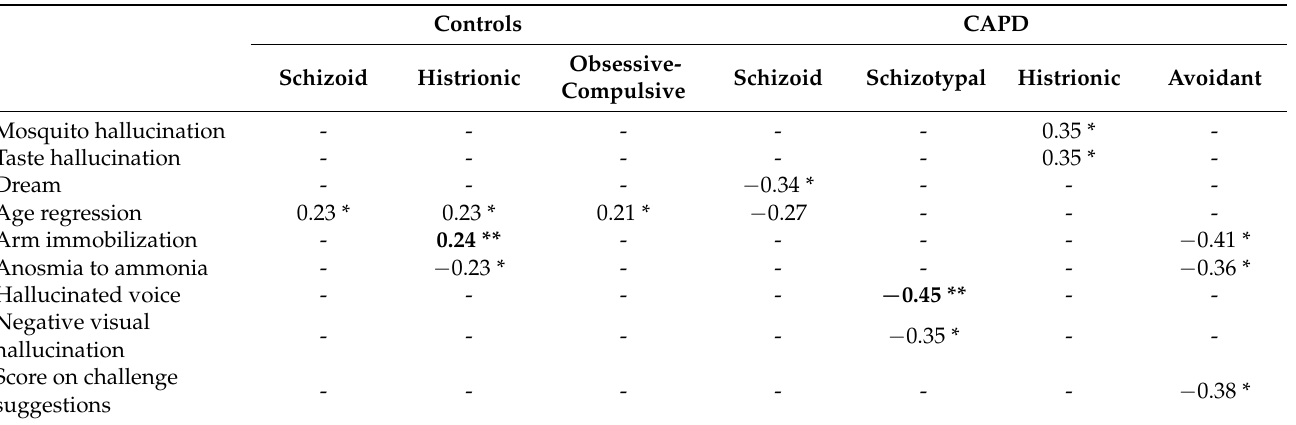
Table 3. Correlations between performance on the Stanford Hypnotic Susceptibility Scale: Form C and personality disorder functioning styles of the Parker Personality Measure in healthy volunteers (controls, n = 115) and cluster A personality disorders (CAPD, n = 36).